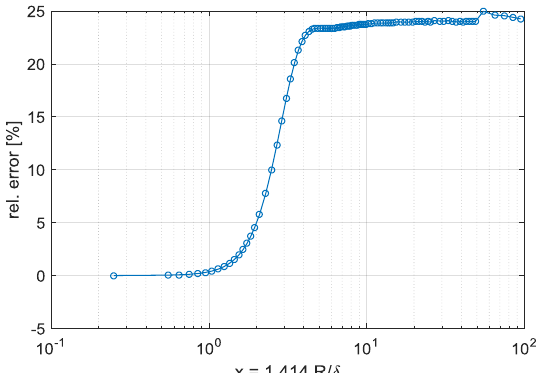
Figure 1: Semi logarithmic plot of the relative error of the linear interpolation of Grover’s Table of the rela- tive internal inductance 𝑇(𝑥) in function of the dimensionless frequency 𝑥